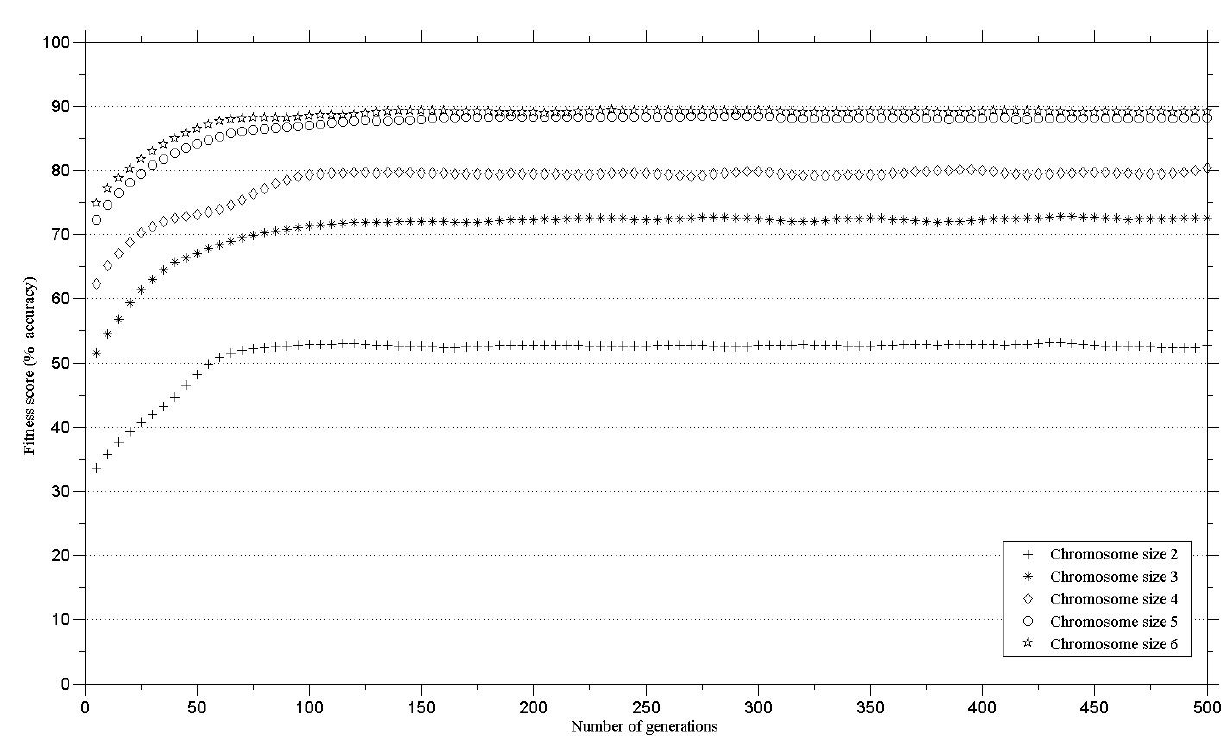
Figure 2. Performance of different sized chromosomes (number of bands in the chromosome) for the classification of 13 vegetation